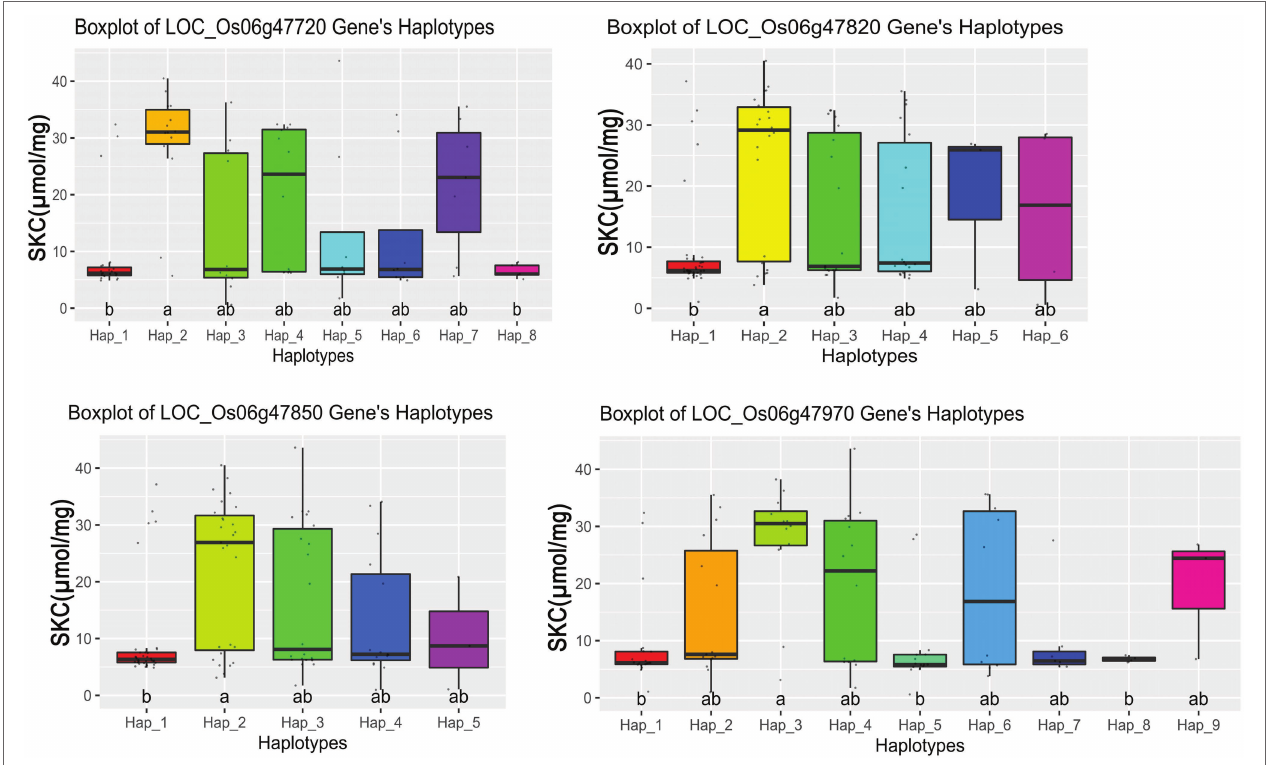
FIGURE 4 | Boxplots for the entire population based on the haplotypes (Hap) for four candidate genes, where the a and b are ranked by Duncan’s test at p <